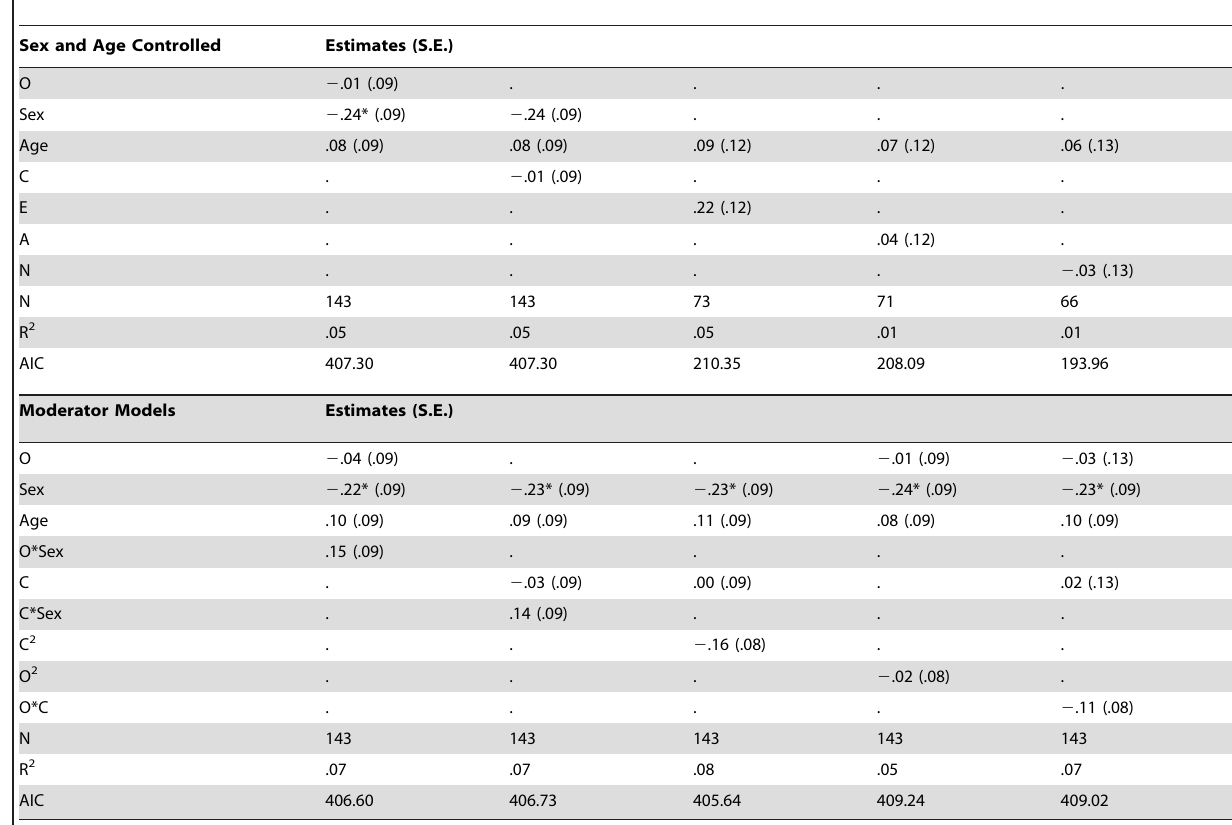
Table 4. Reproductive Success Residuals Regressed on Personality.